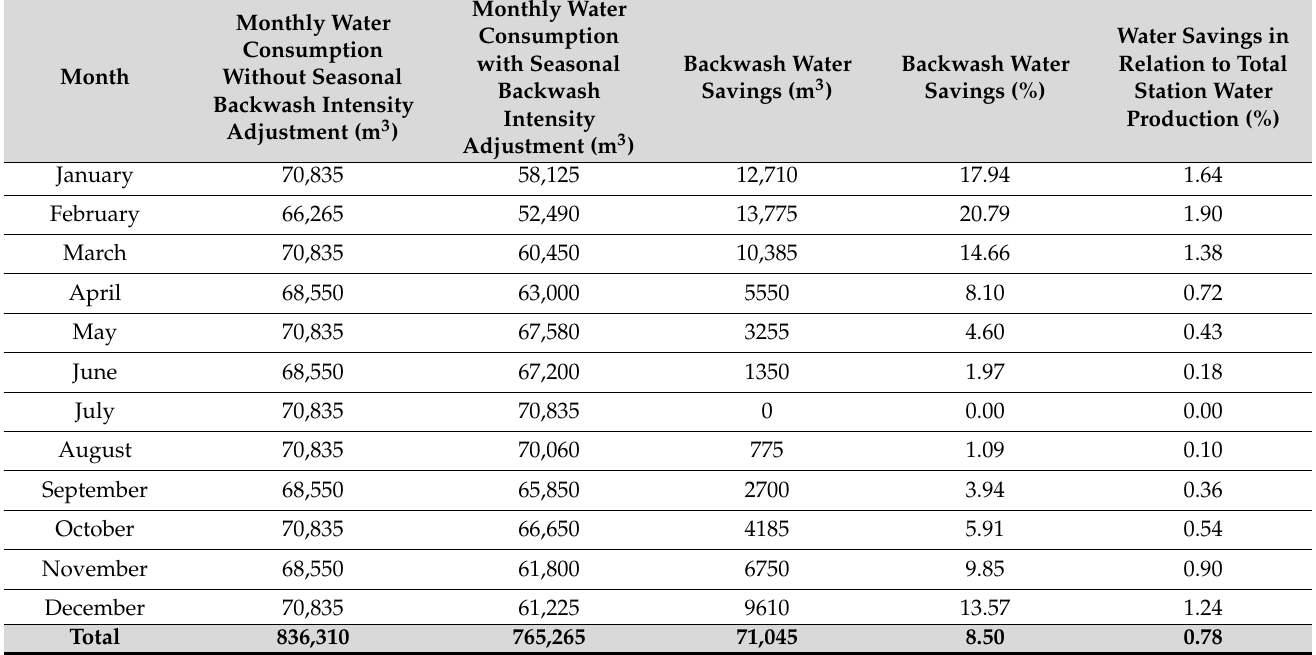
Table 5. Water savings for backwash of rapid filters with monthly adjustment of backwash intensity vs. backwash at constant intensity throughout the year.